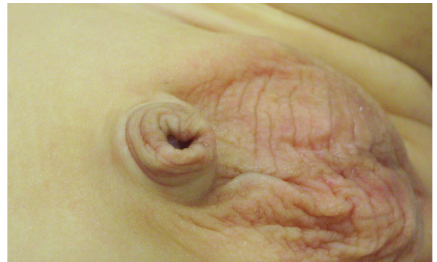
FIGURE 1: Buried penis. 2-year-old boy with a hidden penis secondary to laxity or absence of penoscrotal fixation and some contribution from protuberant suprapubic